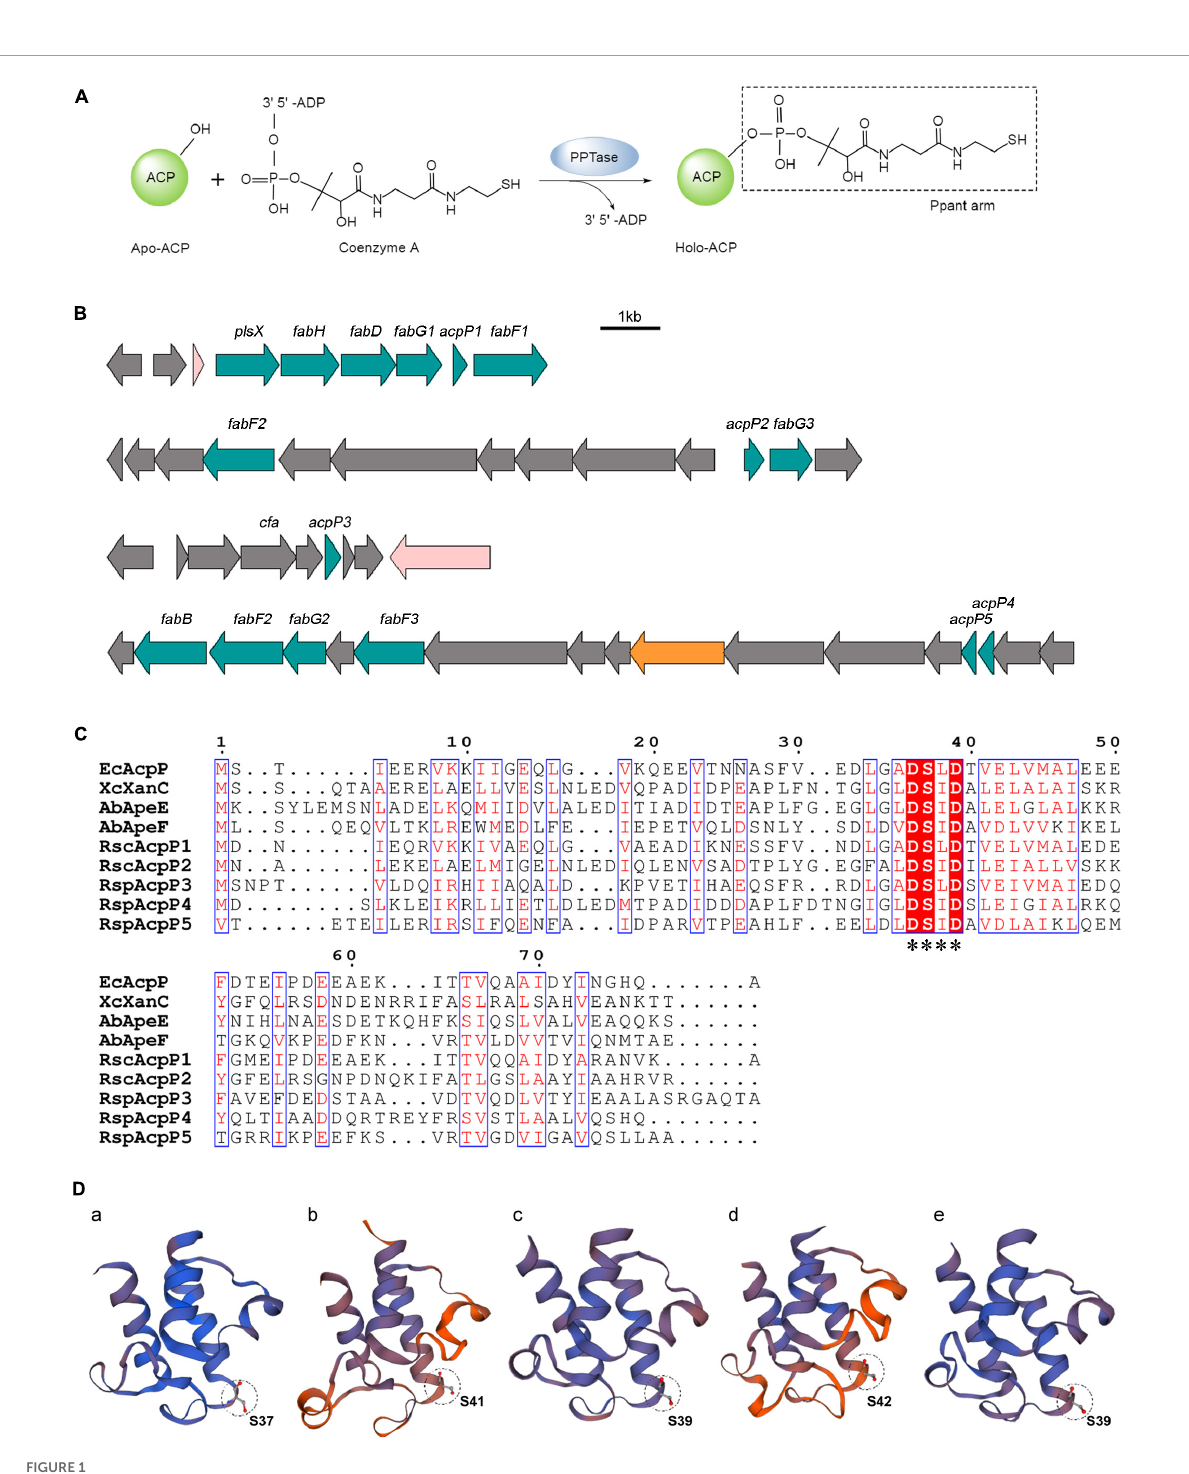
FIGURE1 In silico analysis of R . solanacearum ACPs. (A) Posttranslational modification of acyl carrier proteins (ACPs). Apo -ACP was activated posttranslationally by the attachment of a Ppant arm derived from coenzyme A. The reaction was catalyzed by the 4 (cid:48) -phosphopantetheinyl transferase (PPTase). (B) Genetic organization of five acp genes in the R . solanacearum GMI1000 genome. (C) Sequence alignments of ACPs. The alignments were performed with T-Coffee (http://tcoffee.crg.cat/) and ESPript (https://espript.ibcp.fr/ESPript/ESPript/). White characters with red backgrounds are 100% identical, red characters with blue frames are similar. The conserved motif is labeled with asterisks. (D) Three-dimensional structure prediction of RsACPs using SWISS-MODEL (https://swissmodel.expasy.org/). The circle patterns show the conserved serine active site. (a) AcpP1 (template 4ihf.1.F), (b) AcpP2 (template 2l4b.1.A), (c) AcpP3 (template 3gzm.1.A), (d) AcpP4 (template 2 × 2b.1.A), and (e) AcpP5 (template 1 ×